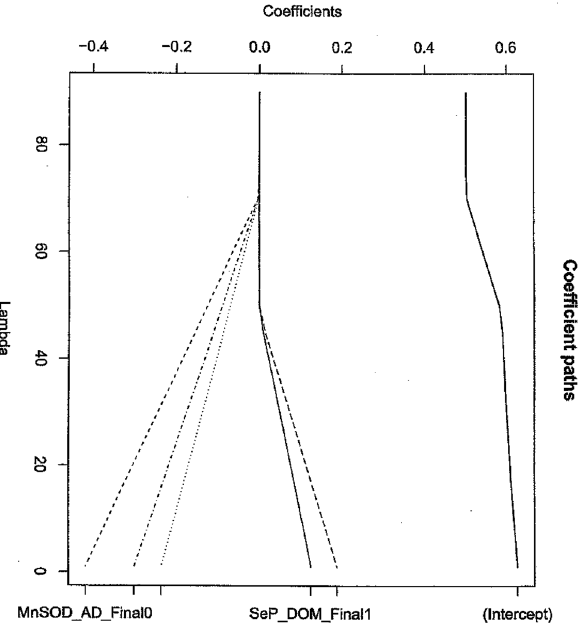
Figure 2. Group lasso Coefficient Plot for Model Containing MnSOD_AD_Final and